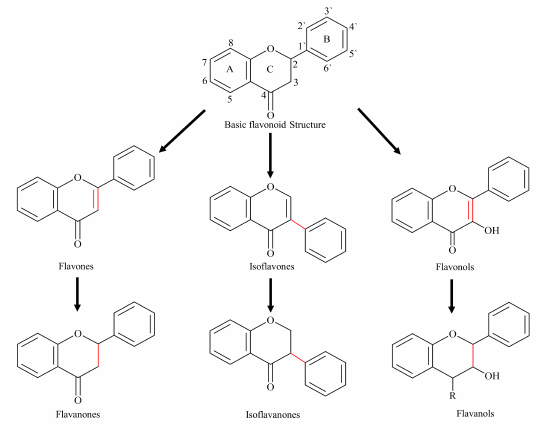
Figure 1. Basic flavonoid backbone and structure of most common